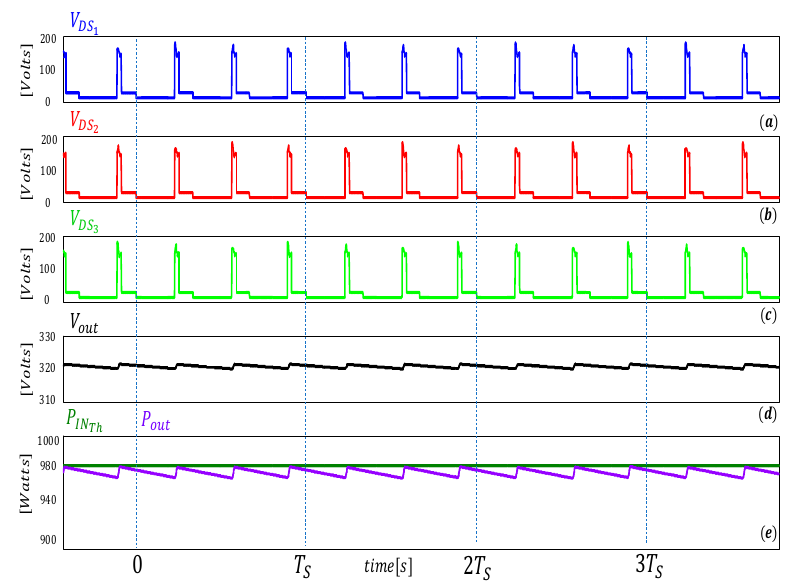
Figure 15. Simulated waveforms: ( a – c ) Drain-source main switches’ voltages. ( d ) Output voltage. ( e ) Input and output power.